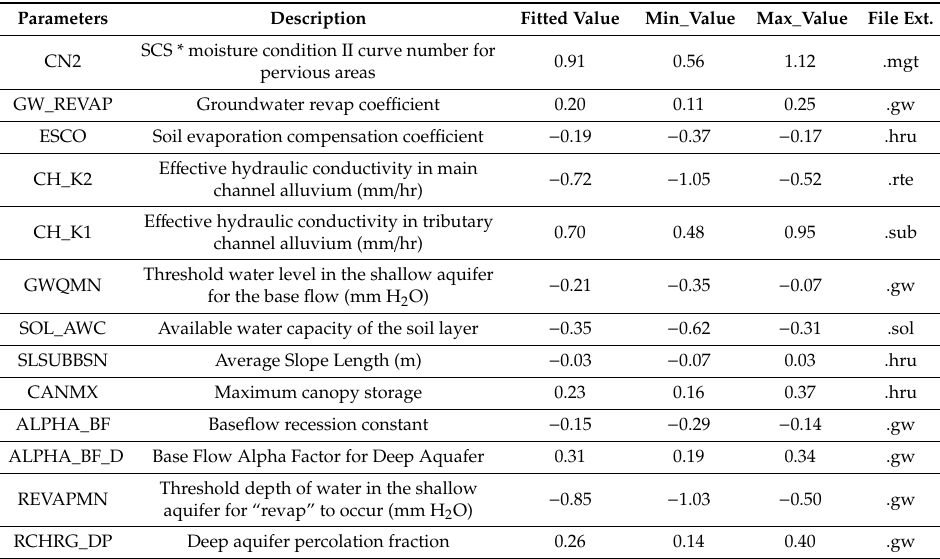
Figure 2. Calibration and validation result for Bellwood station. Table 6. Final Parameters used in SWAT simulation of Upper Choctawhatchee subbasin.